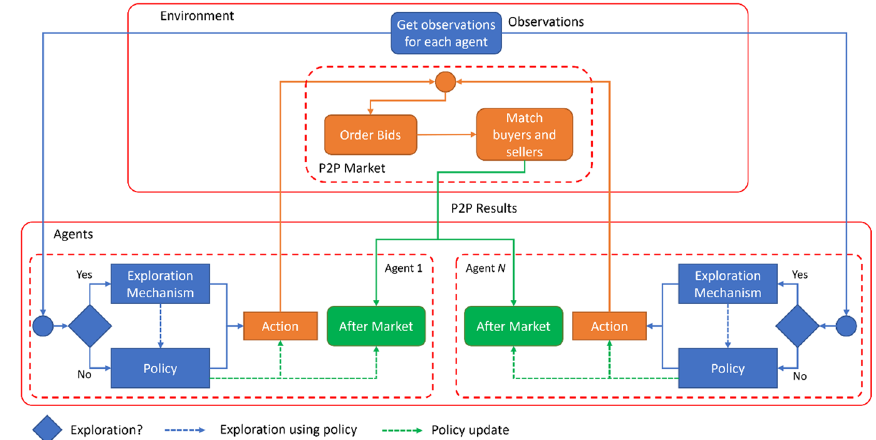
Fig. 3 RL environment and agents interaction in